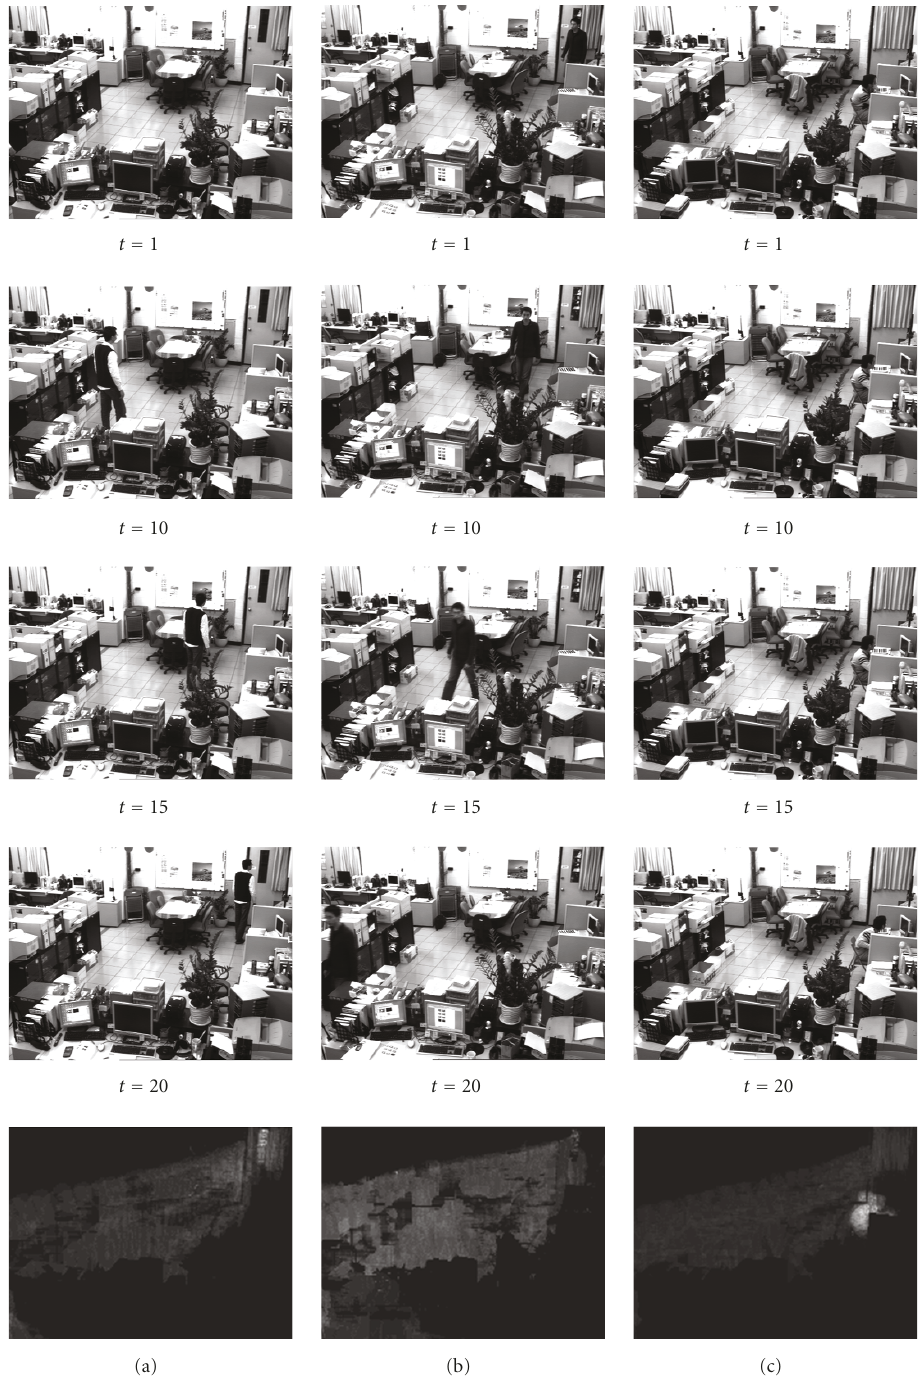
Figure 1: Video sequences involving di ff erent activities of a single person and their corresponding energy maps: (a) single person walking from lower-left to upper-right; (b) single person walking from upper-right to lower-left; (c) single person working on a computer. The corresponding energy map of each column sequence is shown in the bottom